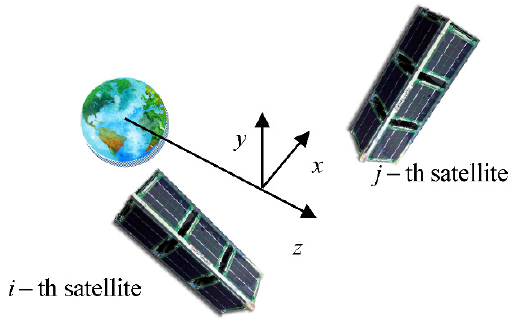
Figure 1. The orbital reference frame.